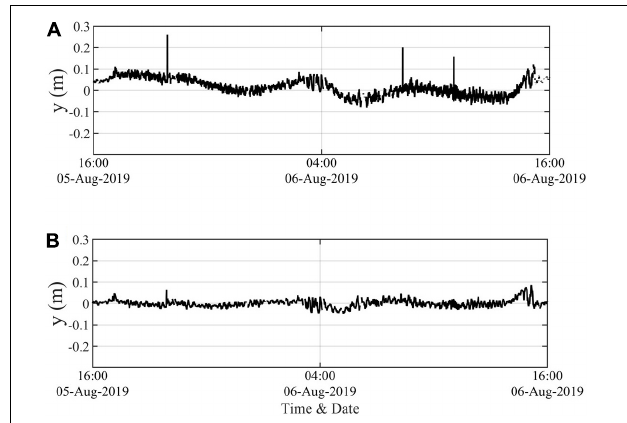
FIGURE 8 | Comparative results of the tidal records (A) before, and (B) after applying the spike removal process.